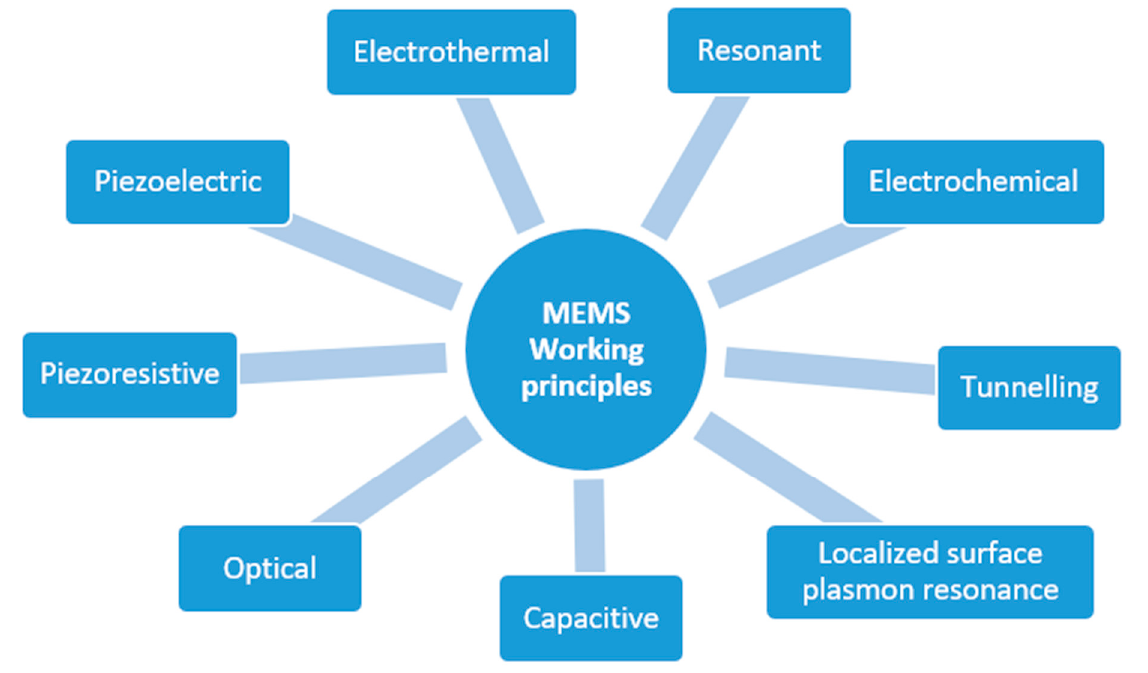
Figure 3. Working principles of MEMS sensors.